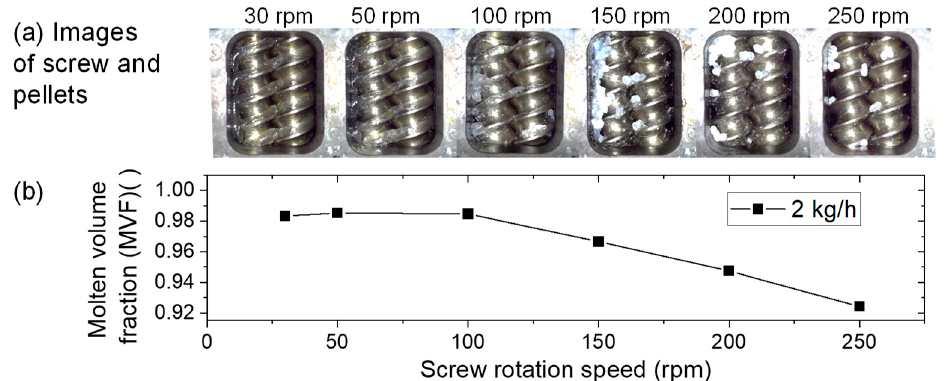
Figure 5. Effect of screw rotation speed on the molten volume fraction (MVF). ( a ) Visual observation and ( b ) MVF. The screw configuration was (B). The feed rate was 2 kg/h. The barrel temperature was 195 °C. The videos of the visual observations are available in the Supplementary Materials.